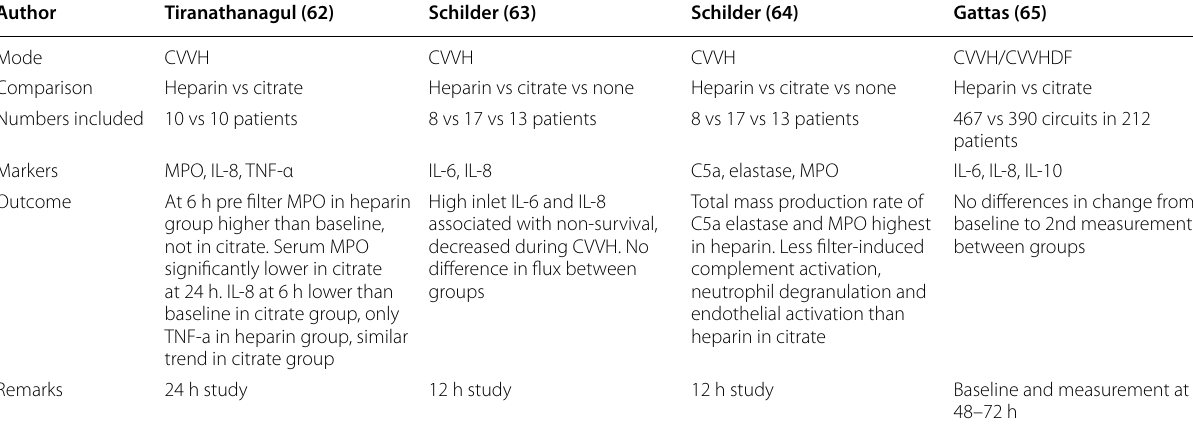
Table 2 Studies describing inflammation and oxidative stress in vivo in RCA CRRT